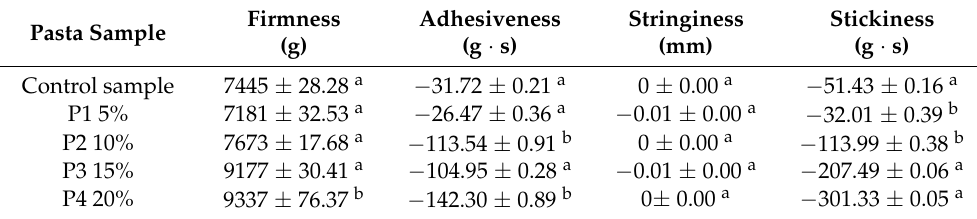
Table 5. Cooked pasta textural parameters.